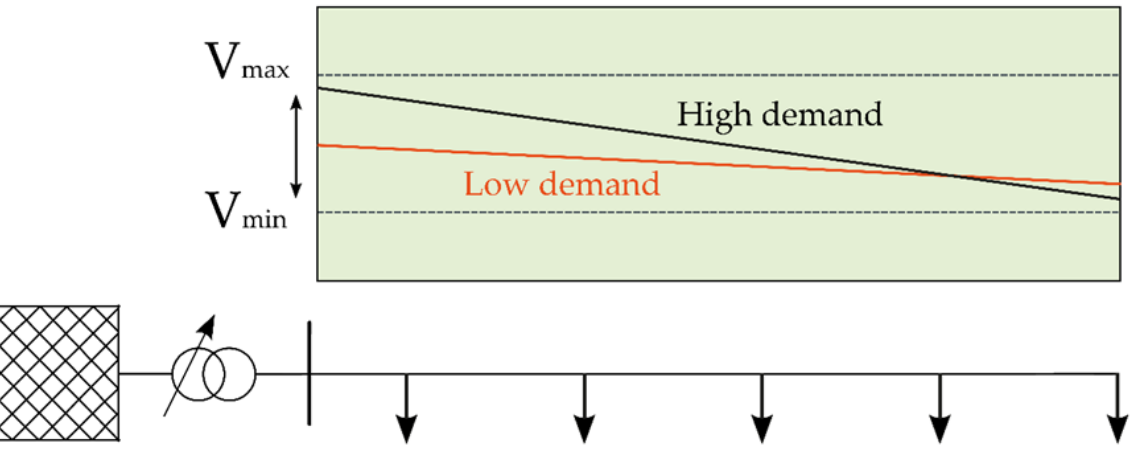
Figure 2. Voltage profile in traditional distribution networks with voltage regulation.